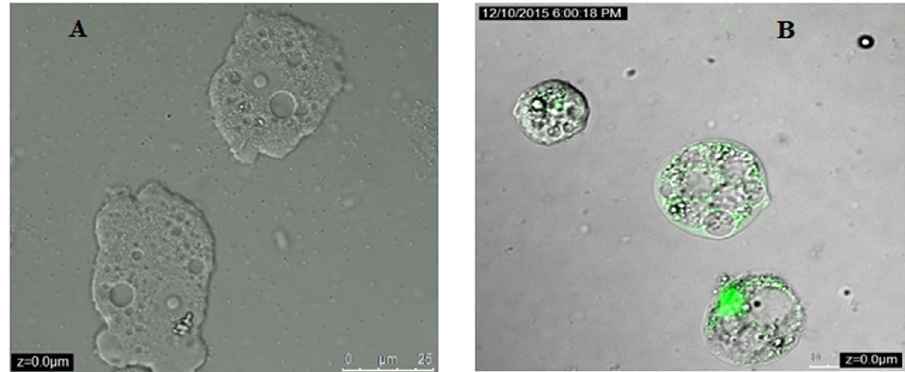
Figure 4. Representative confocal microscopy of Acanthamoeba castellanii Neff labeled with SYTOX Green. Parasite were plated as above and incubated for 24 h with IC 90 of the Systane Ultra (B), Negative control (untreated strains) Acanthamoeba castellanii . Neff.